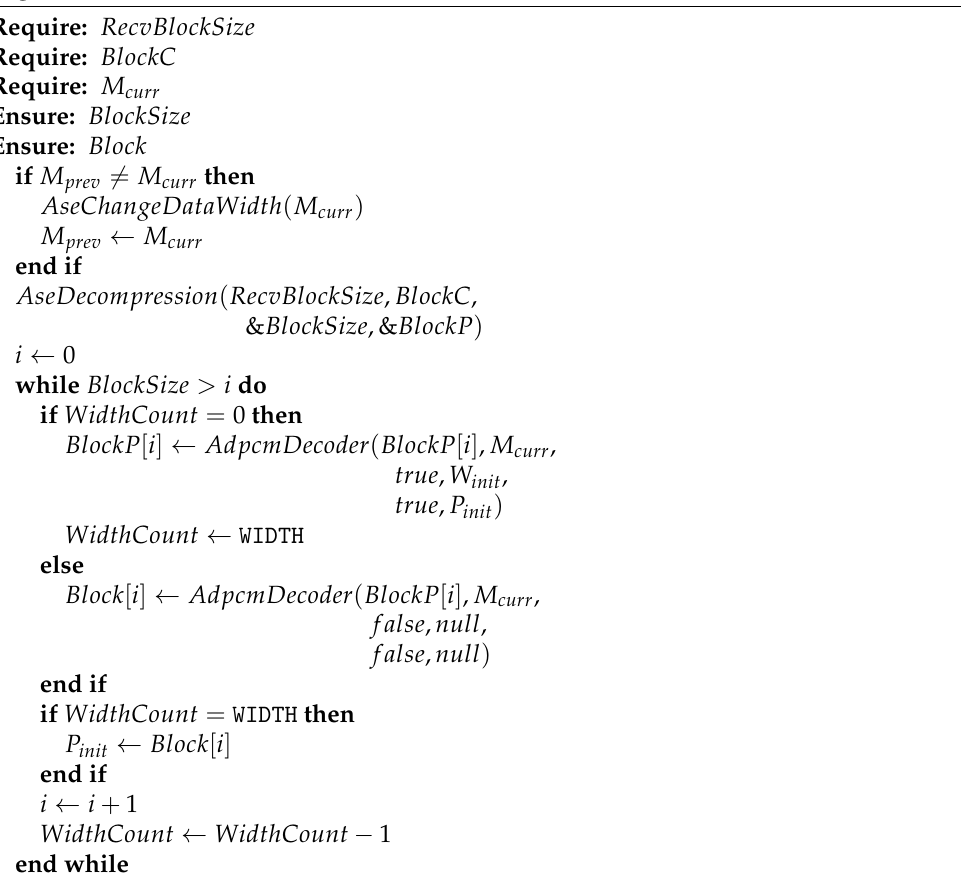
Algorithm 8 Consumer